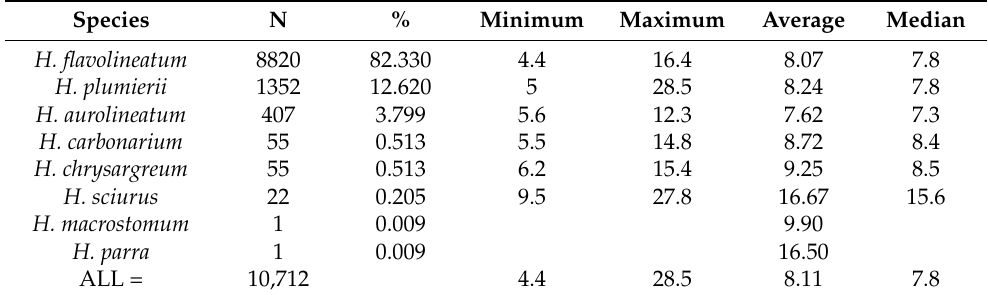
Table 2. Descriptive statistics for fork length (cm) by species of all juvenile Haemulon spp. observed in resting schools found in the Majimo/Caracoles area of the initial mark-recapture study. Includes samples for both tagging and recapture. N is the number of fish caught and